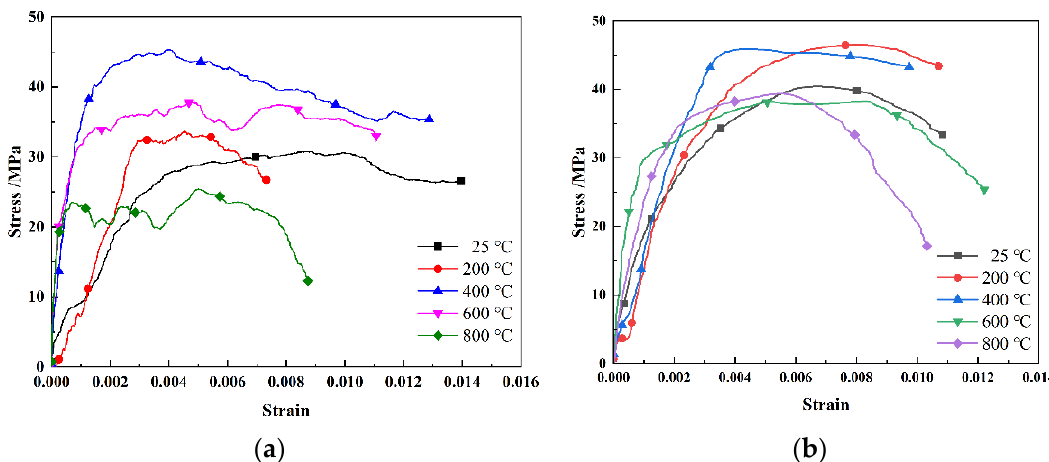
Figure 6. Dynamic stress–strain curves at different temperatures. ( a ) Impact velocity = 5.3 m/s; ( b ) Impact velocity = 8.6 m/s.